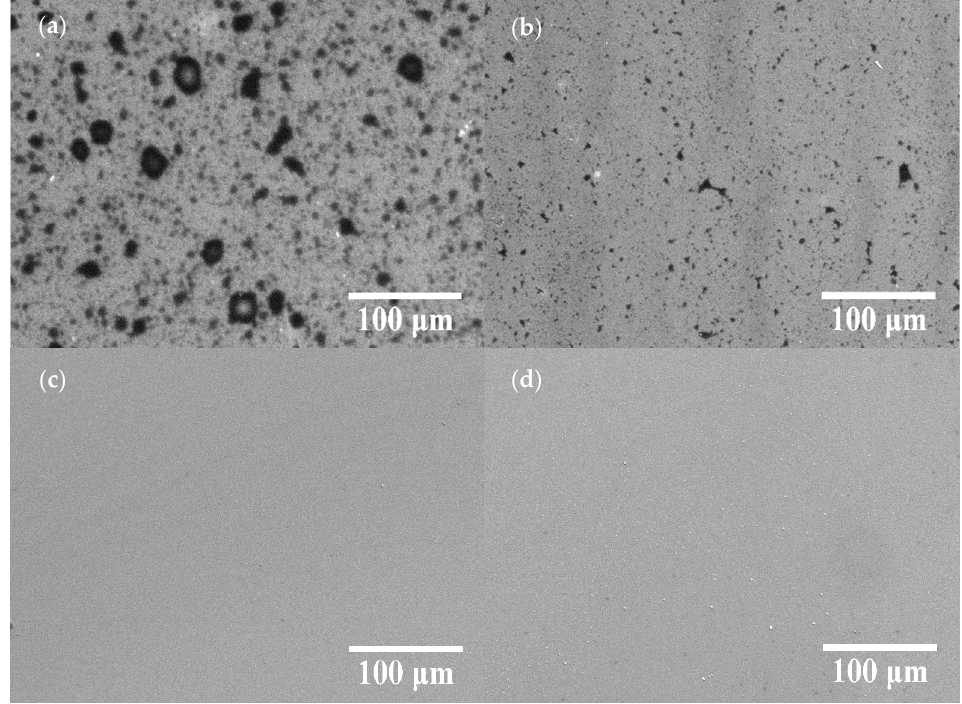
Figure 2. SEM images of COOH-APTMS/SiO 2 /Si with different modification times: ( a ) 1 h; ( b ) 2 h; ( c ) 3 h; ( d ) 4 h.